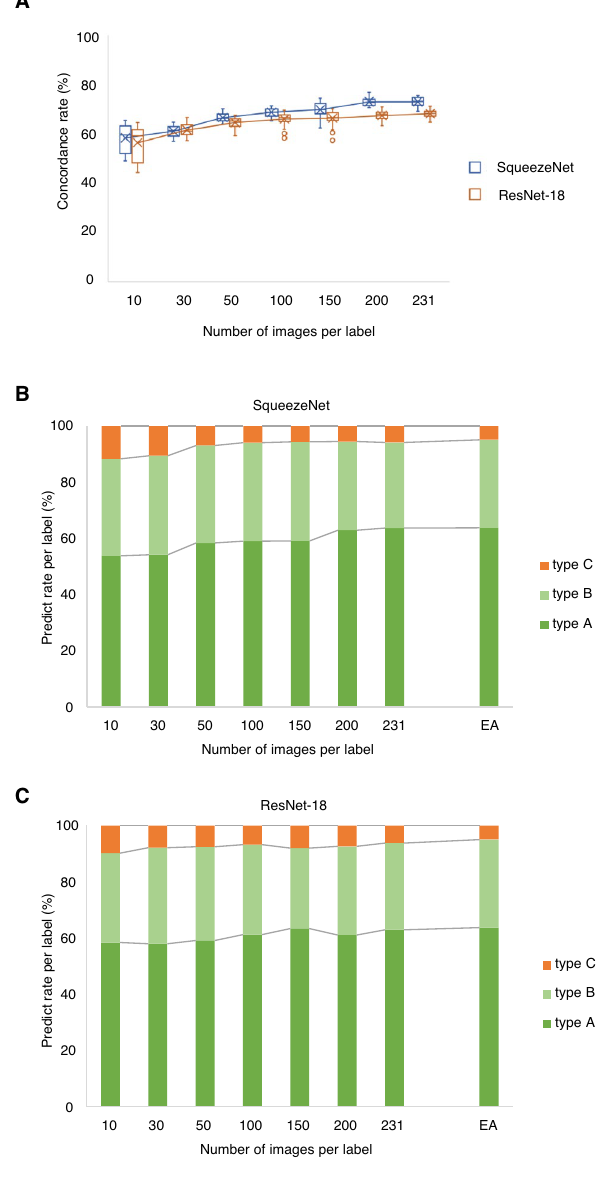
Figure 3. Chromosome type classifications by the trained models. ( A ) Concordance rates between EA and model’s PA for each number of training images per label. ( B and C ) Distribution of each type of chromosome for each number of training images per label in SqueezeNet ( B ) and in ResNet-18 ( C